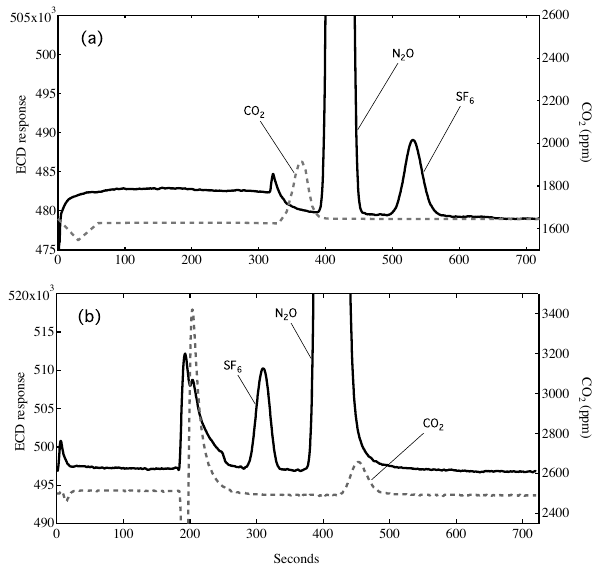
Figure 2: Sample chromatograms from two-column N 2 O/SF 6 analysis system (upper panel, 521 Fig. 2. Sample chromatograms from two-column N 2 O/SF 6 analysis version 2) and three-column system (lower panel, version 3) (see Table 1). CO 2 was measured at 522 system (upper panel, version 2) and three-column system (lower the outlet of the ECD. 523 panel, version 3) (see Table 1). CO 2 was measured at the outlet of the